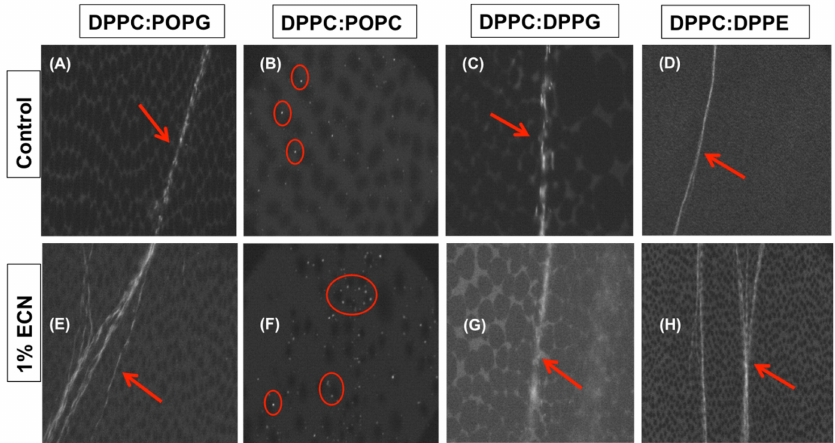
Figure 7. Fluorescence micrographs taken after monolayer collapse ( A ) DPPC:POPG (7:3) control, ( B ) DPPC:POPC (7:3) control, ( C ) DPPC:DPPG (7:3) control, ( D ) DPPC:DPPE (7:3) control, ( E ) DPPC:POPG (7:3) with 1 wt% ECN, ( F ) DPPC:POPC (7:3) with 1% ECN, ( G ) DPPC:DPPG (7:3)